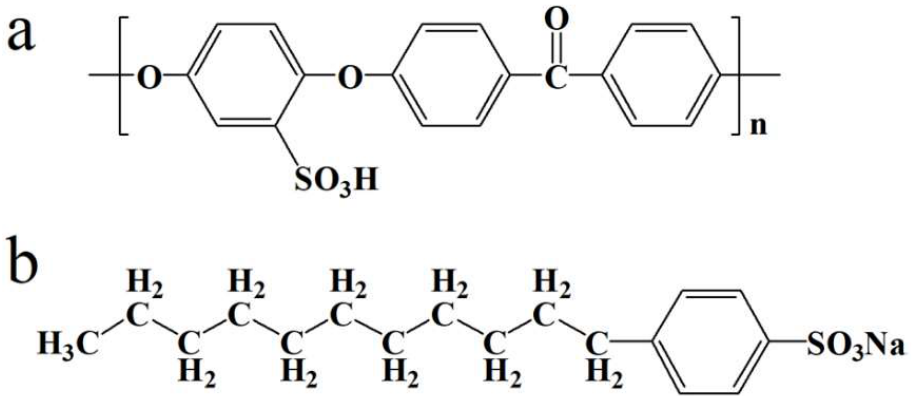
Figure 1. Structural formulae of ( a ) sulfonated poly(ether ether ketone) (SPEEK) and ( b ) sodium dodecyl benzene sulfonate (SDBS).